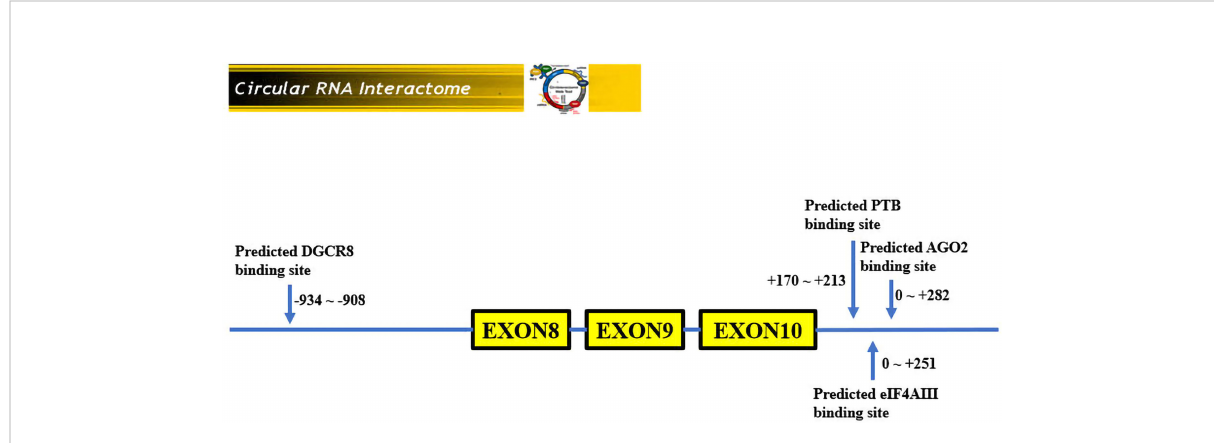
FIGURE 4 RNA binding proteins with hsa_circ_0007990. According to the CircInteractome database, the 3 ′ start fl anking intron upstream of hsa_circRNA_0007990 has a potential binding region with DGCR8 protein, and the 3 ′ start fl anking intron downstream of hsa_circRNA_0007990 has a potential binding region with Ago2, EIF4A3, and PTB